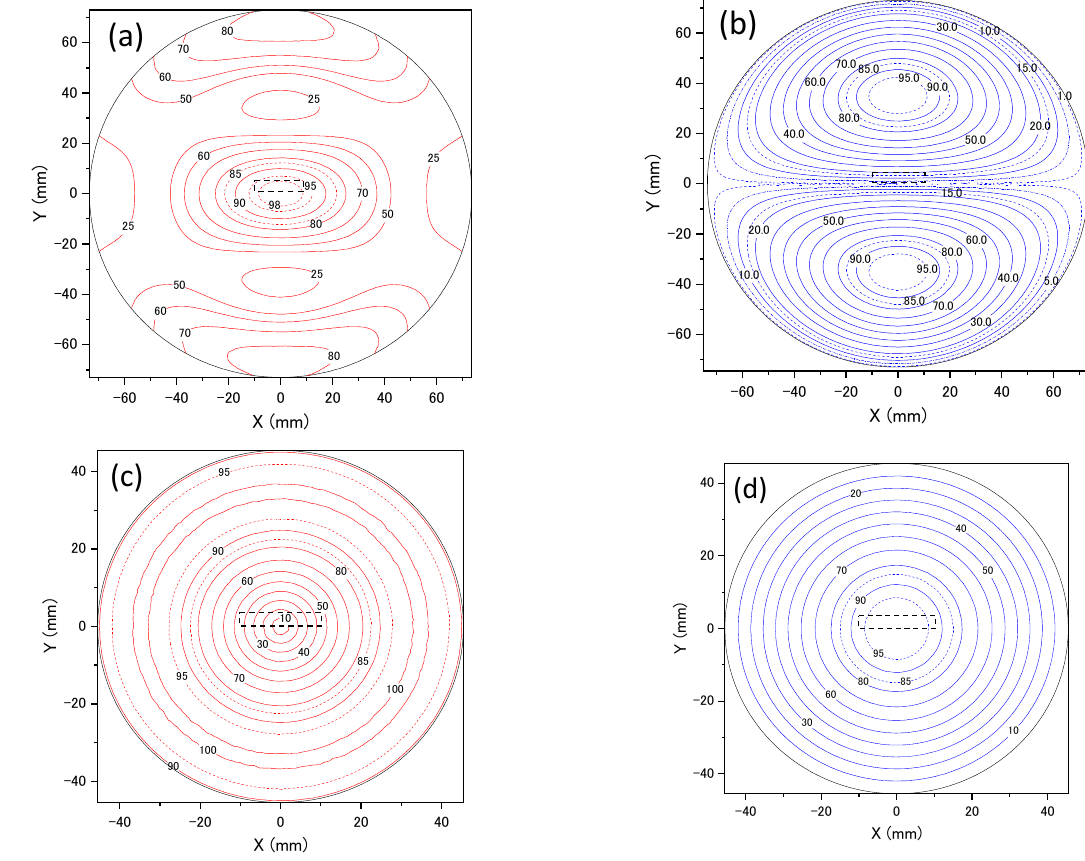
Figure 2. Distribution of electromagnetic field in a cavity for the TM 110 magnetic field ( a ), TM 110 electric field ( b ), TM 010 magnetic field ( c ), and TM 010 electric field of ( d ). The black dashed lines indicate the sizes of the samples placed in the centers of the cavities.